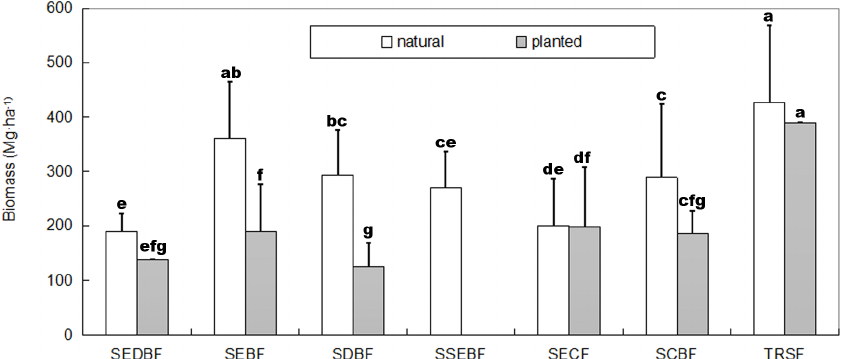
Figure 3. Average forest biomass in mature natural and mature planted forests. Biomass with different letters among forest types and between natural and planted forests are significantly different (one ‐ way ANOVA and t ‐ test, p < 0.05).